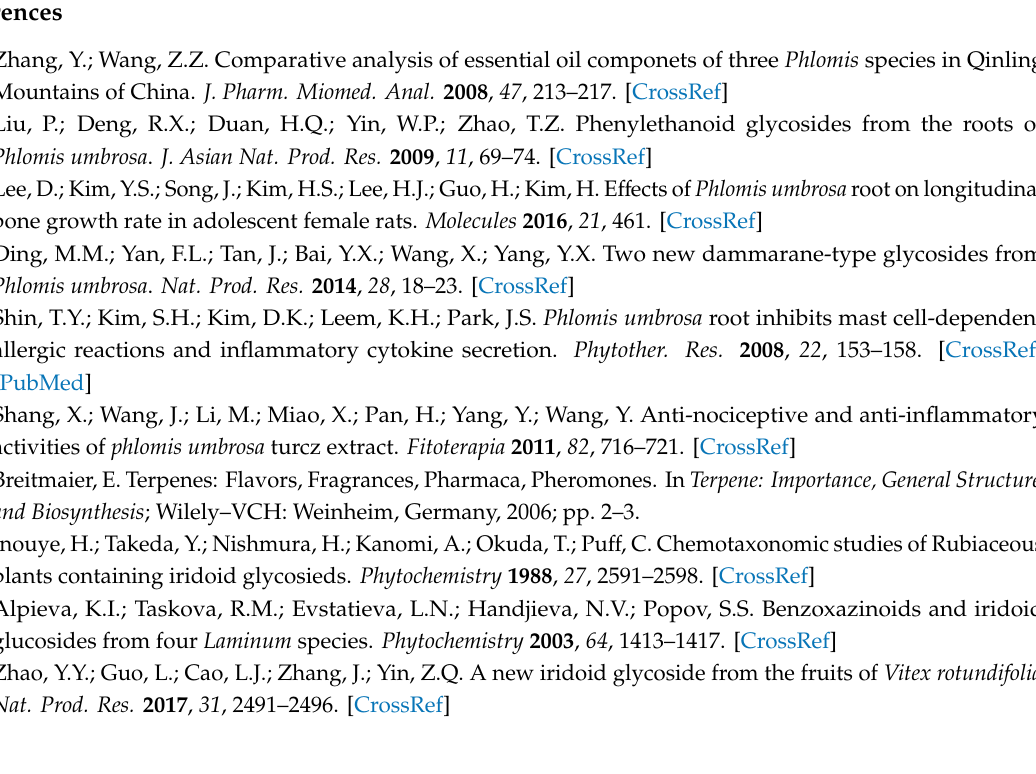
Figure S7: Deduced amino acid multiple sequence alignments of the PuHMGR with other HMGRs; Figure S8: Deduced amino acid multiple sequence alignments of the PuMK with other MKs; Figure S9: Deduced amino acid multiple sequence alignments of the PuPMK with other PMKs; Figure S10: Deduced amino acid multiple sequence alignments of the PuMVD with other